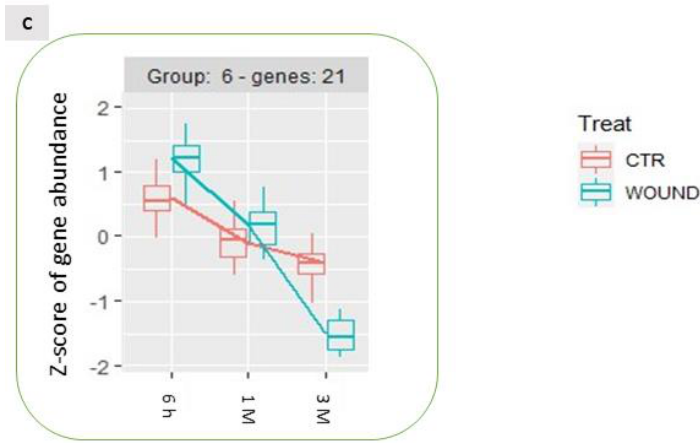
Figure 6. Time-course expression profiles identified by the time per treatment analysis among storage-regulated DEGs in control and wounded apples, highlighting the significantly different temporal dynamics of expression of specific groups of genes (( A – C ); see text for details) as a consequence of wounding. The data refer to samples collected in 2019.